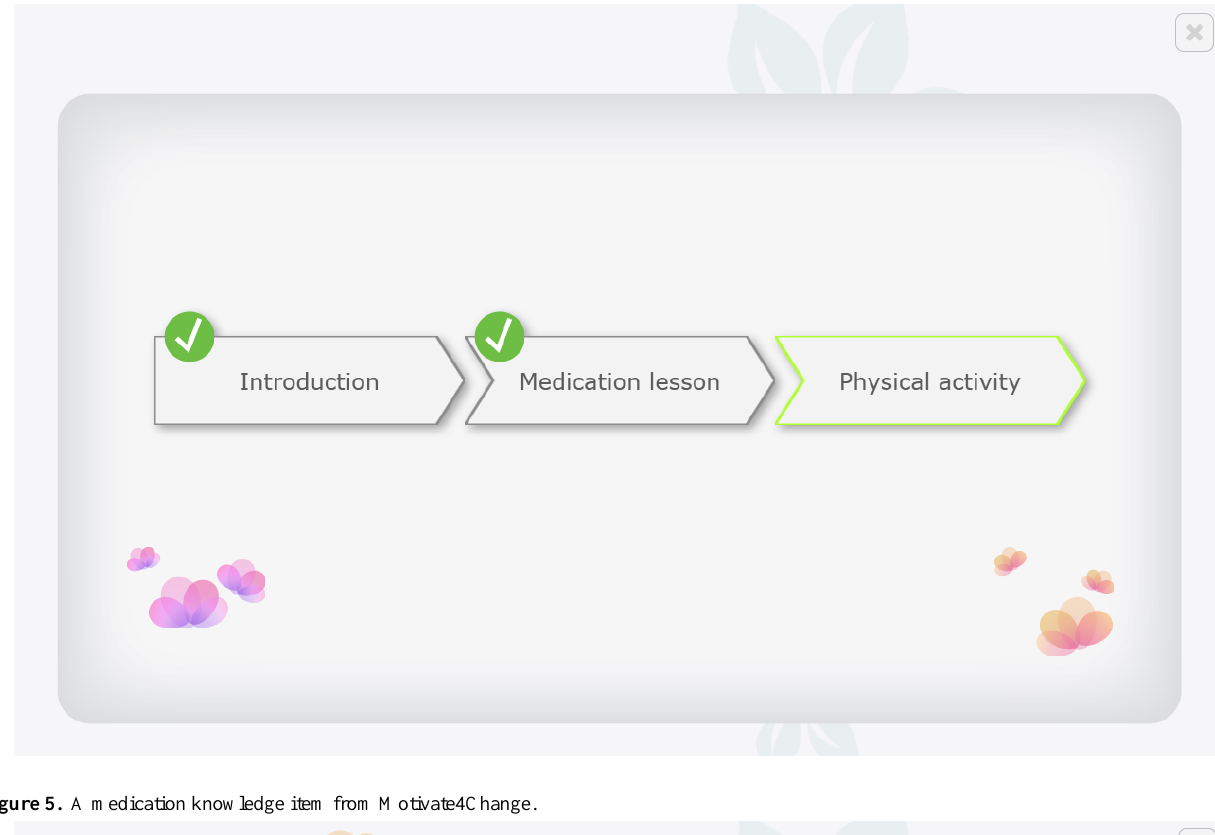
Figure 4. The Motivate4Change program menu.